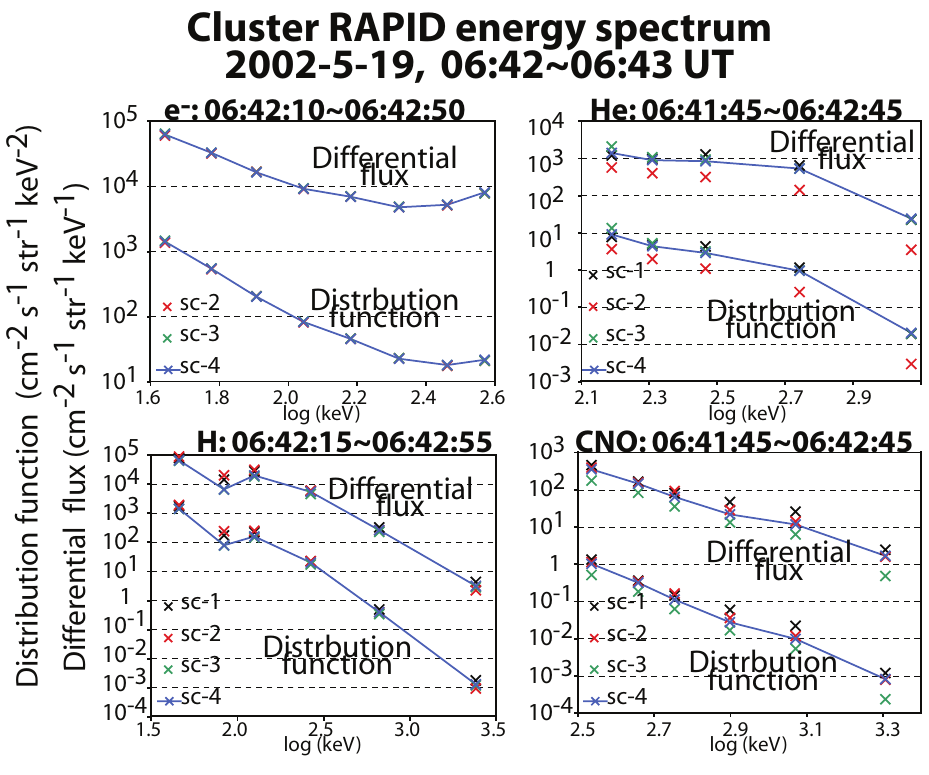
Fig. 11. Normalized distribution function for (a) electron, (b) proton, (c) helium, and (d) oxygen during 06:42:18 ∼ 06:42:52UT (averaged over 9 spins) just before the 06:43UT event. Here we simply divided the differential flux by energy, which is proportional to the distribution function by a factor of 0 . 5 M 2 , where M is the mass of the ion. Since error bar is large in the energy direction, which is the denominator from count to differential flux and from differential flux to distribution function, we also show less erroneous differential flux. Even with such large error bar, the data show good match into a smooth curve and good agreement between different spacecraft, giving some reliability in the plot. For example, the positive slope of the electron distribution function at the highest energy is real beyond the possible error